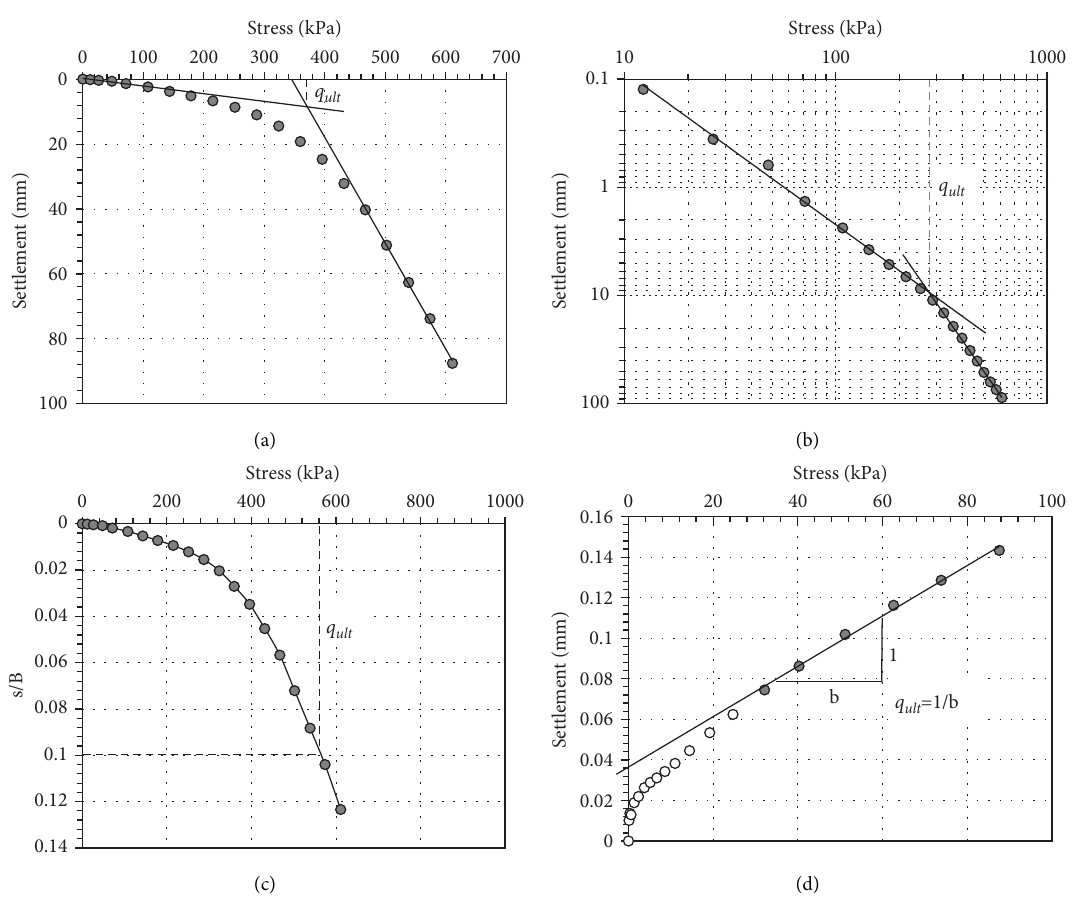
Figure 2: Methods for determining ultimate bearing capacity from load test results: (a) tan tangent intersection method, (b) log-log method, (c) 0.1B method, and (d) hyperbolic